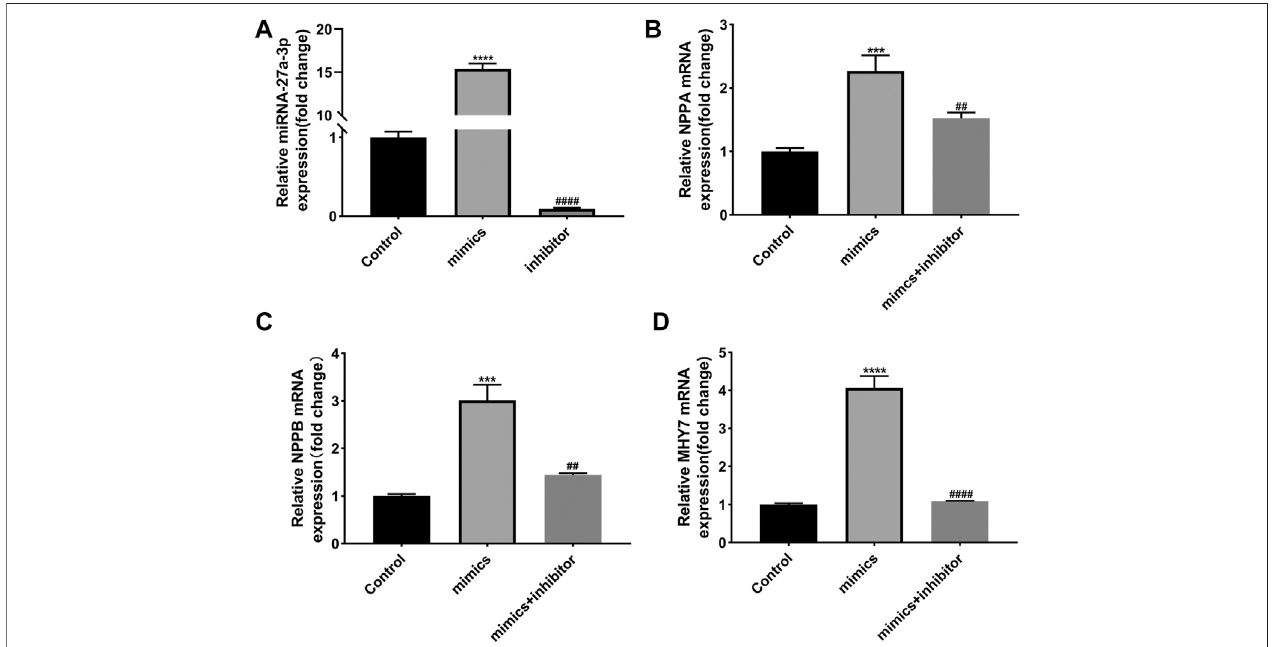
FIGURE 3 | Effects of miR-27a-3p-mimics and inhibitor on cardiomyocytes. (A) The expression of miR-27a-3p in miR-27a-3p-mimics and miR-27a-3p-inhibitor treatment group. (B – D) The expressions of NPPA, NPPB, and MHY7 in miR-27a-3p-mimics treatment group and miR-27a-3p-mimics + miR-27a-3p-inhibitor co- treatment group. All the values are the mean of three independent experiments ( n (cid:2) 3). **** p < 0.0001, *** p < 0.001 vs. control, ### p < 0.0001, ## p < 0.01 vs. mimics.